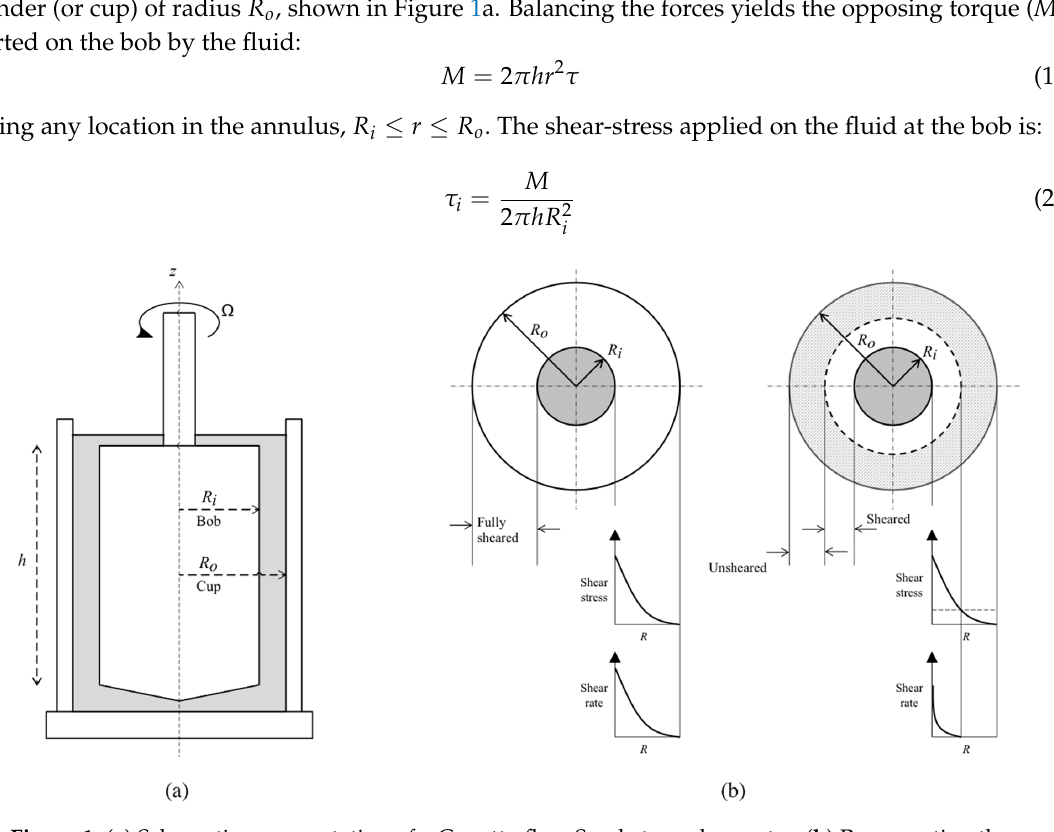
Figure 1. ( a ) Schematic representation of a Couette-flow Searle type rheometer. ( b ) Representing the shear-rate and shear-stress distribution for the fully and partially sheared flow modes.